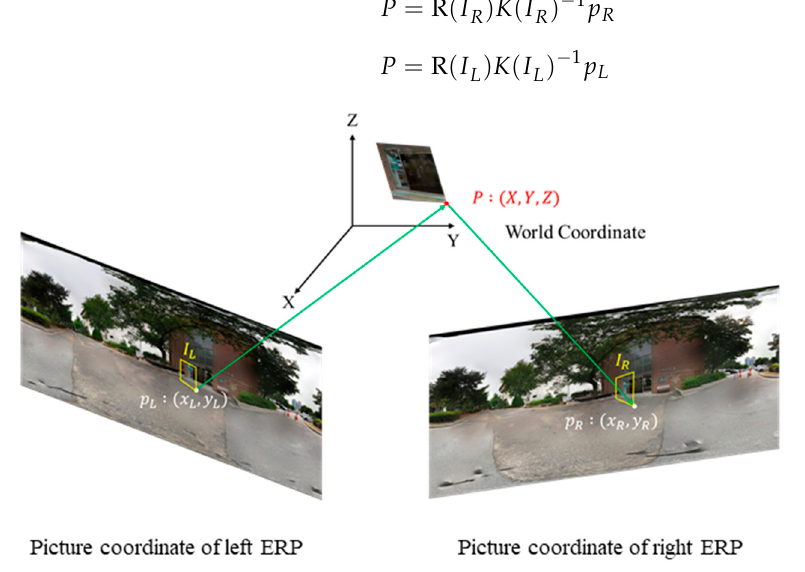
Figure 4. Relationship between world coordinates and picture coordinates.